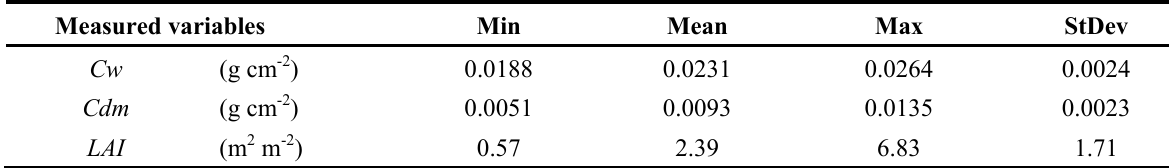
Table 4. Summary statistics of the measured biophysical and biochemical variables of grassland sample